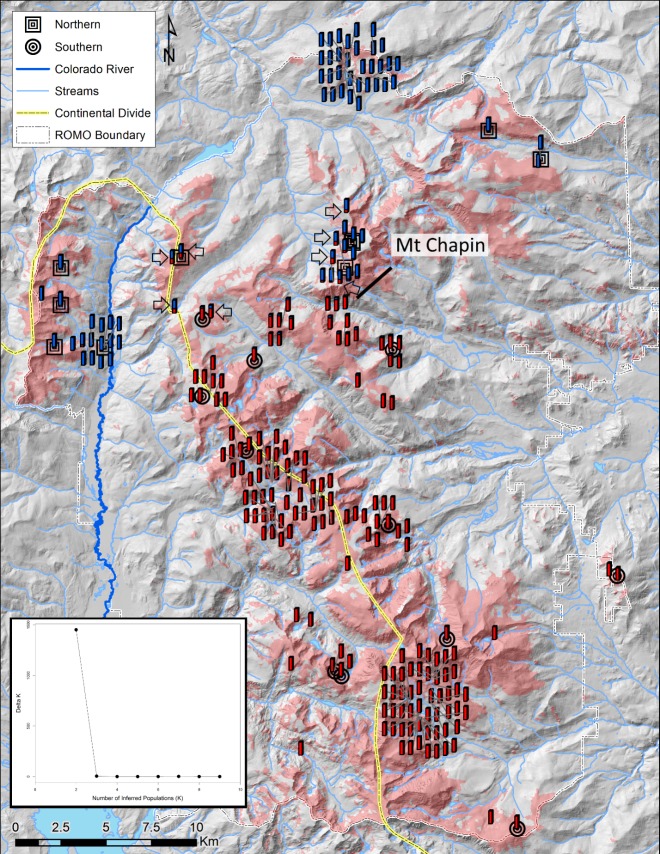
Population genetic structure within Rocky Mountain National Park.Individuals are shown as bar plots representing probability of assignment (q values) from the Structure analysis for K = 2. Individuals cluster geographically as a northern and southern population, separated by Mt. Chapin and the Colorado River. Concentric, black squares and circles indicate the placement of sequenced individuals into the northern and southern mtDNA lineages, respectively (Fig 6). Red shading indicates potential pika habitat [54]. Inset Figure shows ΔK values, indicating support for K = 2. Hillshade background was derived from the USGS National Elevation Dataset, streams and lakes were from the National Hydrography Dataset (https://nationalmap.gov).